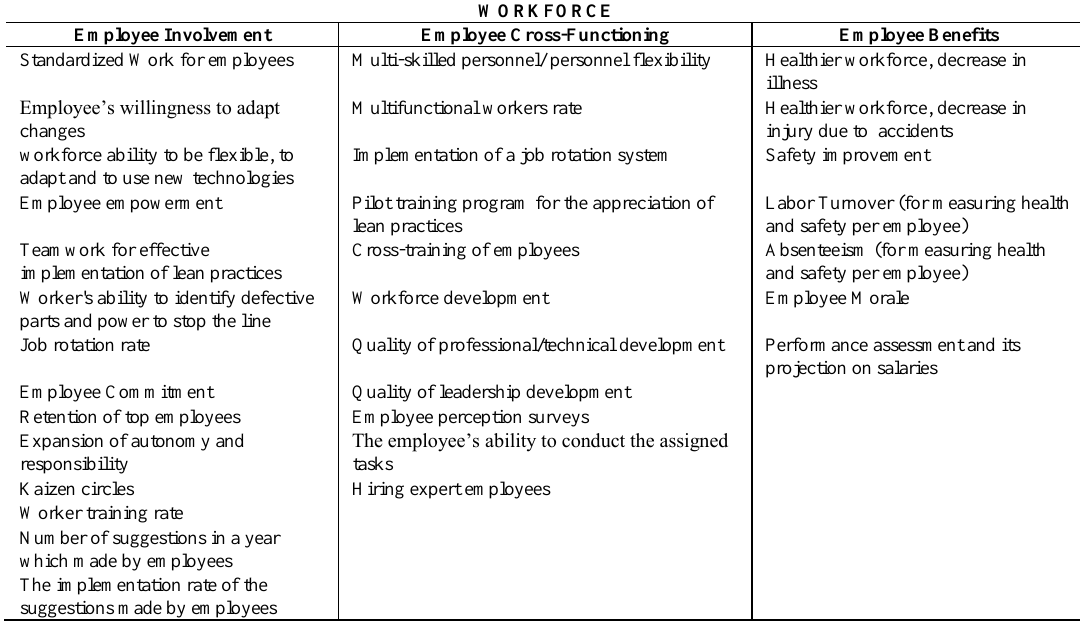
Table 8. Sub-criteria and measures for the workforce main